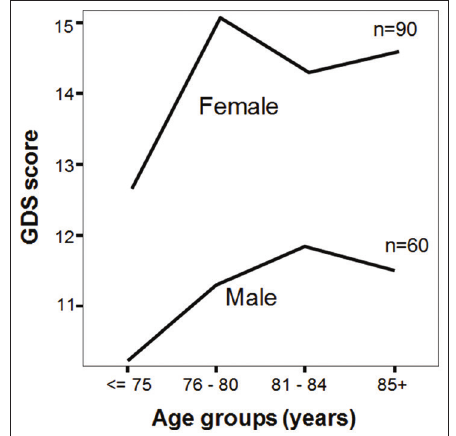
FIGURE 2. Relationship between GDS score and age